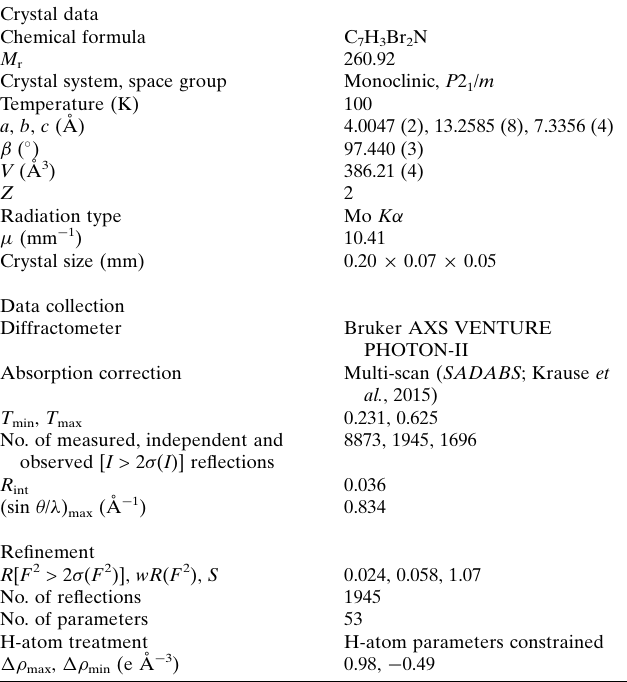
Table 2 Experimental details. Crystal data Chemical